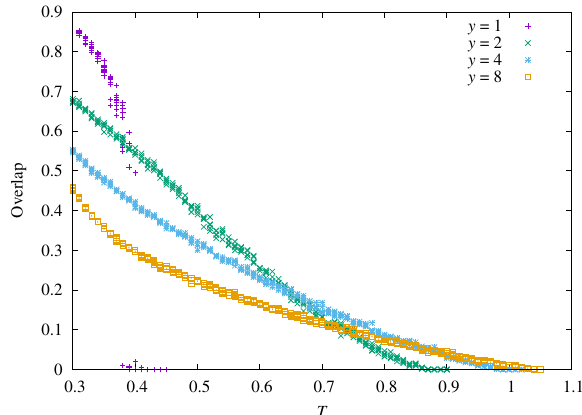
FIG. 16. Overlap between the fixed point reached by BP initialized near a planted glassy state at T and the glassy configuration planted at T , as a function of the planting temper- ature T for different values of the replicas y at c ¼ 17 , N ¼ 10 4 , γ ¼ 1 . At each temperature, the results for five different planted graphs are shown. T d is located as the lowest temperature at which the overlap reaches 0. As long as y > 1 , the transition becomes